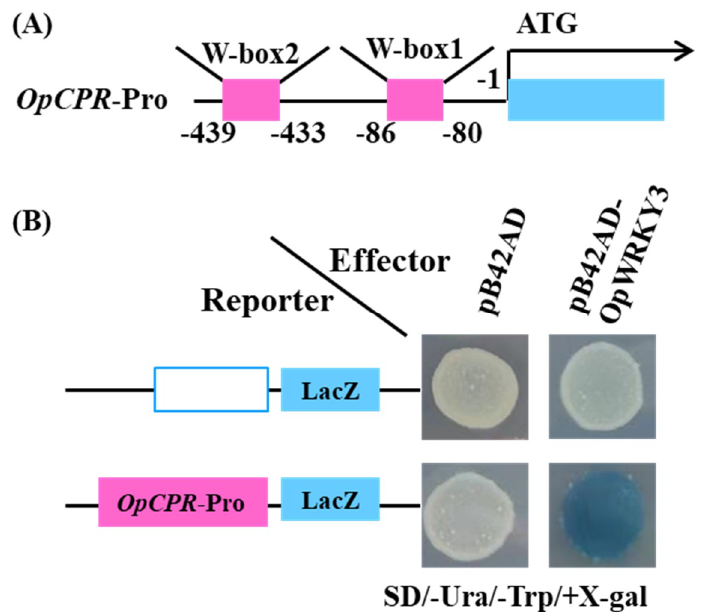
Figure 7. OpWRKY3 binds to the W-box of the OpCPR promoter and activates OpCPR expression. ( A ) The analysis of motifs in OpCPR promoter. ( B ) Yeast one-hybrid assay showed that OpWRKY3 binds to the W-box of OpCPR promoter.